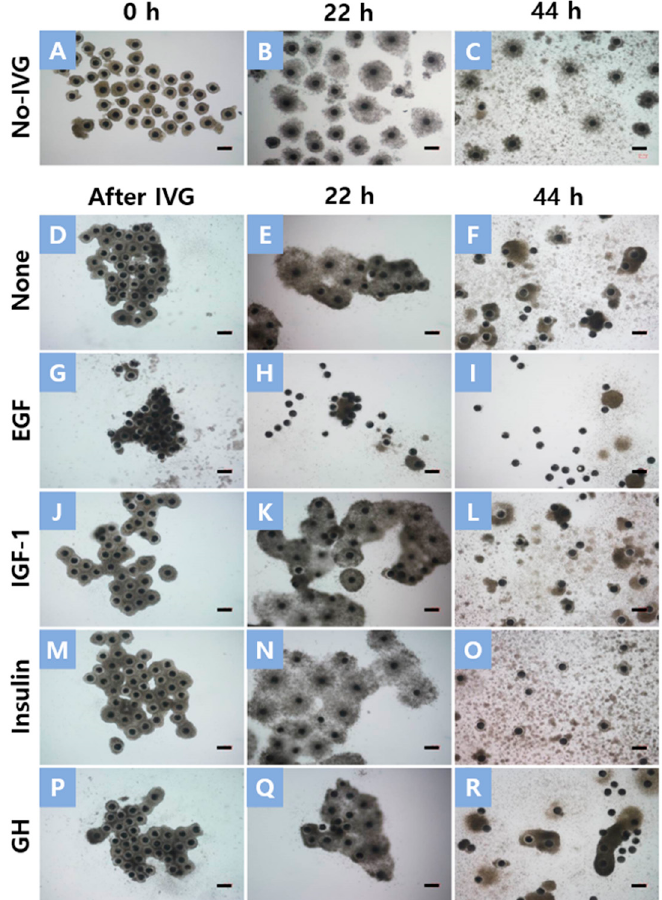
Figure 1. Morphology of cumulus–oocyte complexes (COCs) after in vitro growth (IVG) and in vitro maturation (IVM) culture. COCs without IVG culture ( A ) and COCs that had been cultured for 2 days in an IVG medium supplemented with None ( D ), epidermal growth factor (EGF) ( G ), insulin-like growth factor-1 (IGF-1) ( J ), insulin ( M ), and growth hormone (GH) ( P ). No-IVG COCs and IVG COCs were cultured for 22 h in an IVM medium with FSH and human chorionic gonadotrophin ( B , E , H , K , N , Q ) and then cultured for an additional 22 h in an FSH and human chorionic gonadotrophin-free medium ( C , F , I , L , O , R ). Scale bar = 200 µ m. Table 3. Effect of growth factor and hormone treatment during in vitro growth (IVG) culture on intra-oocyte glutathione (GSH) and reactive oxygen species (ROS) contents after IVM. Treatment during